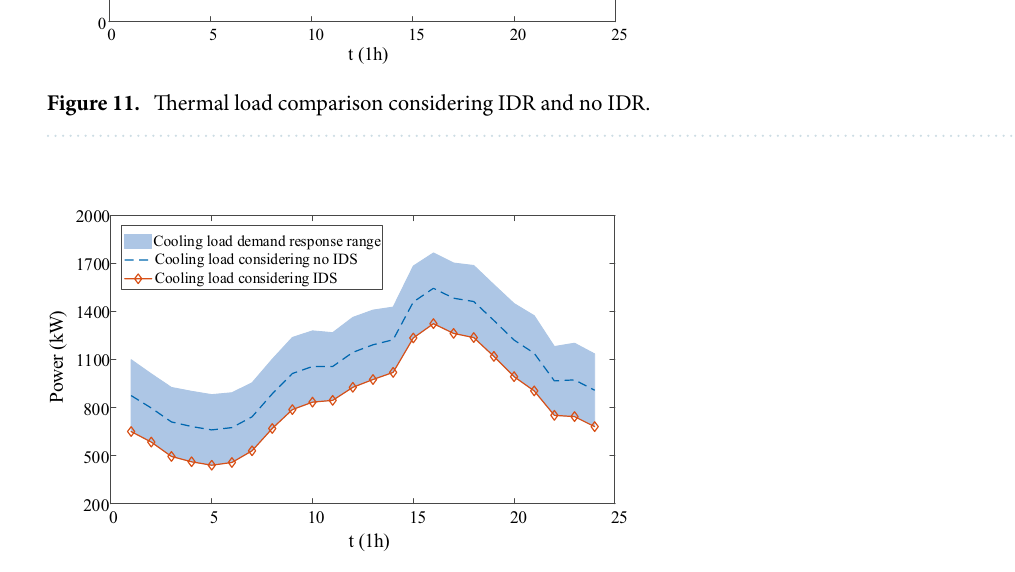
Figure 12. Cooling load comparison considering IDR and no